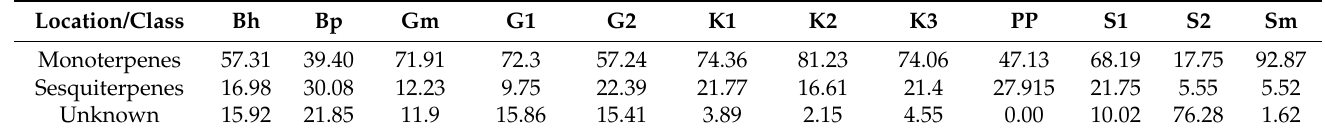
Table 8. Mean classes of monoterpenes, sesquiterpenes, and the unknown group obtained from 11 populations of S. kitaibelii and S. montana ssp. montana (cultivated).